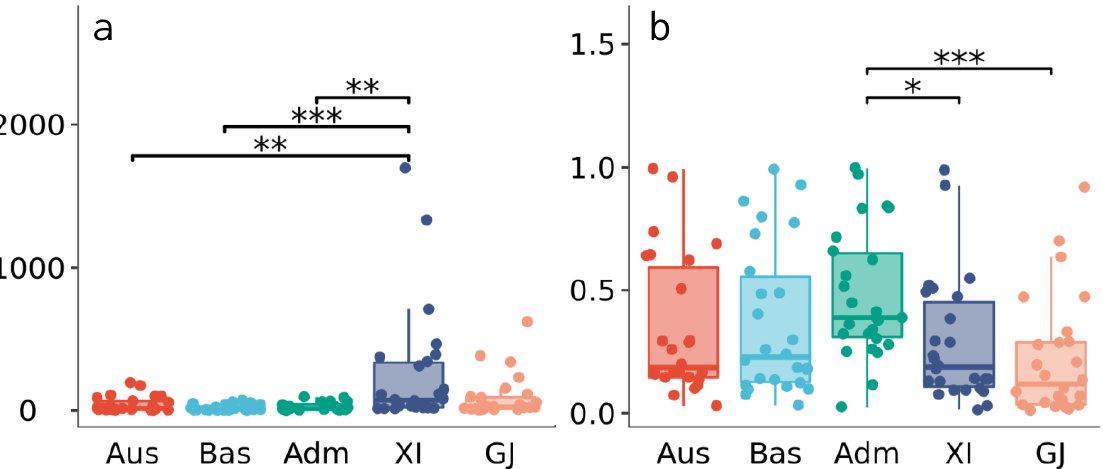
Figure 4. Haplotype analysis of the AGC gene family in 3010 rice genomes (3KRG). ( a ) Distribution of gene–CDS–haplotype number (gcHapN) in different populations. ( b ) Distribution of equitability values ( E H ) in different populations. Bas , Basmati ; Adm , Admixtures ; XI , Xian / Indica ; GJ , Geng / Japonica ; Different colors represent different populations; * Difference is significant at p < 0.05 level among different populations; ** Difference is significant at p < 0.01 level among different populations; *** Difference is significant at p < 0.001 level among different populations.